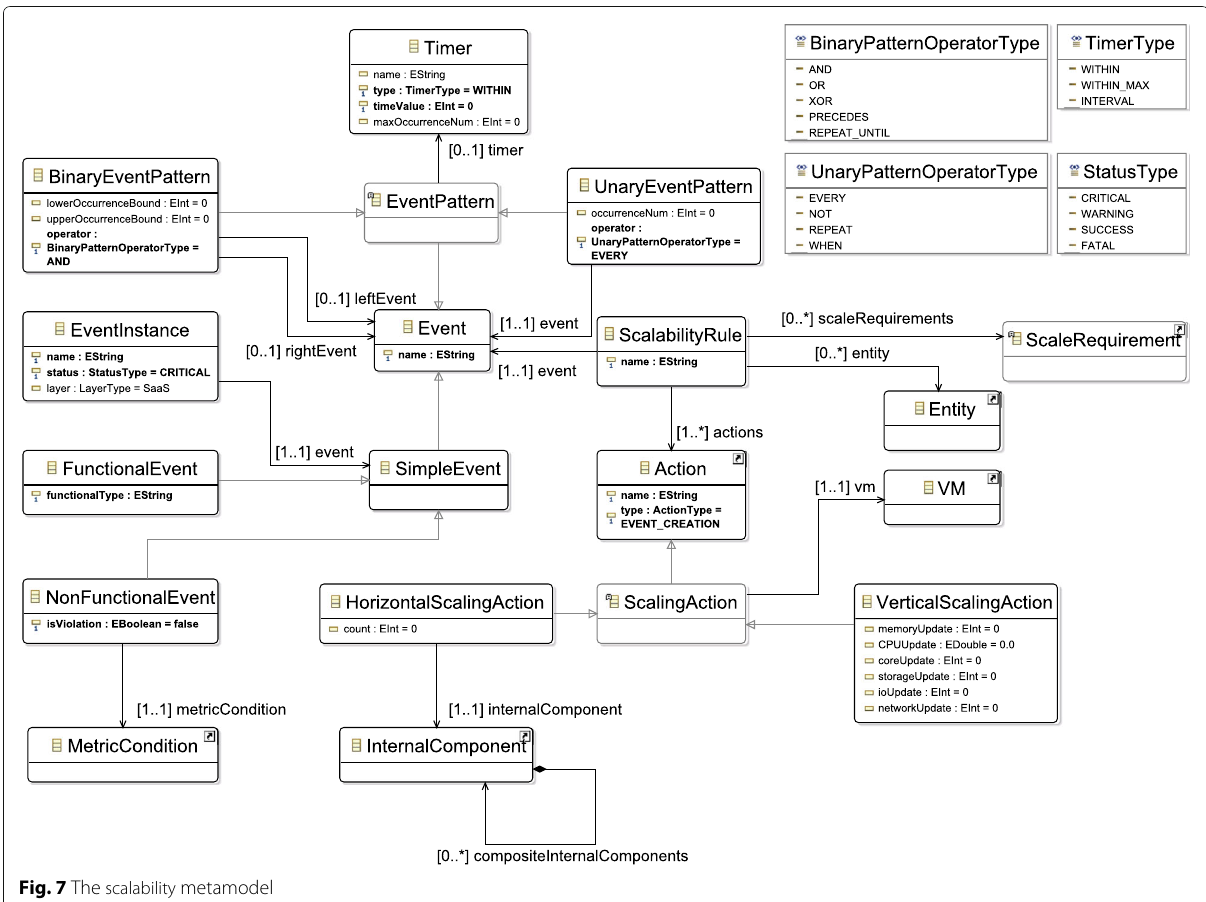
Fig. 7 The scalability metamodel